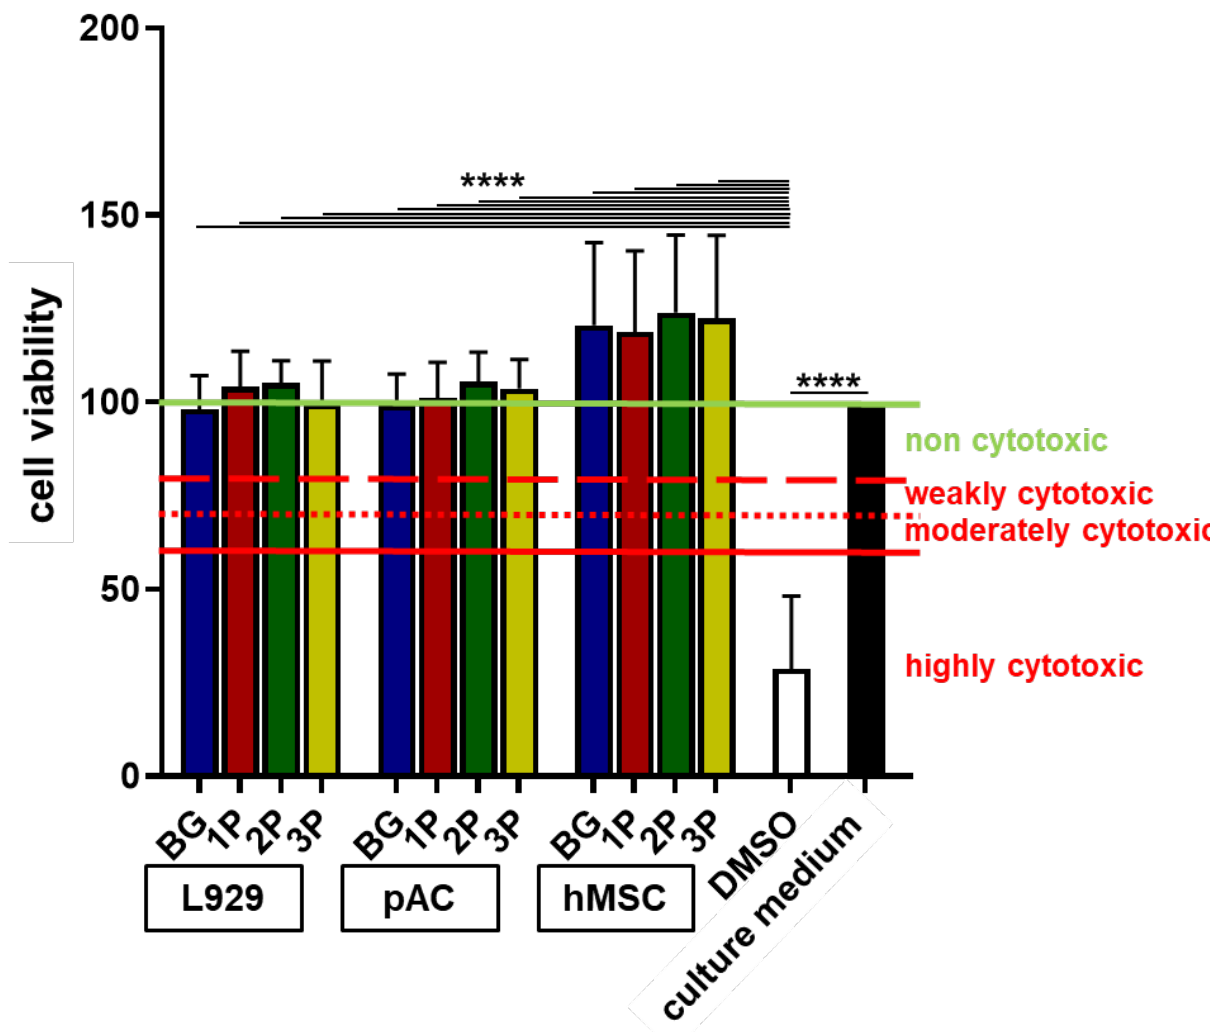
Figure 5. Cytotoxicity Assay using BG (blue bars), 1P (red bars), 2P (green bars) and 3P (yellow bars) scaffold extracts. Viability of L929, porcine articular chondrocytes (pACs) and human mesenchymal stem cells (hMSCs) treated for 24 h with scaffold extracts (48 h extraction) from three different scaffold batches. Cell viability was above 90% in cells treated with all scaffold extracts. Cell viability of the positive control with 10% dimethyl sulfoxide (DMSO, white bar) was below 30% and that of the negative control with culture medium (black) was 100%. The CellTiter 96 ® Aqueous One Solution Cell Proliferation Assay was used to assess cytotoxicity. The pure bioactive glass (BG, blue), single (1P, red), twofold (2P, green) and threefold PLGA infiltrations (3P, yellow). n = 3. Ordinary one-way ANOVA with multiple comparison, p values: **** p <